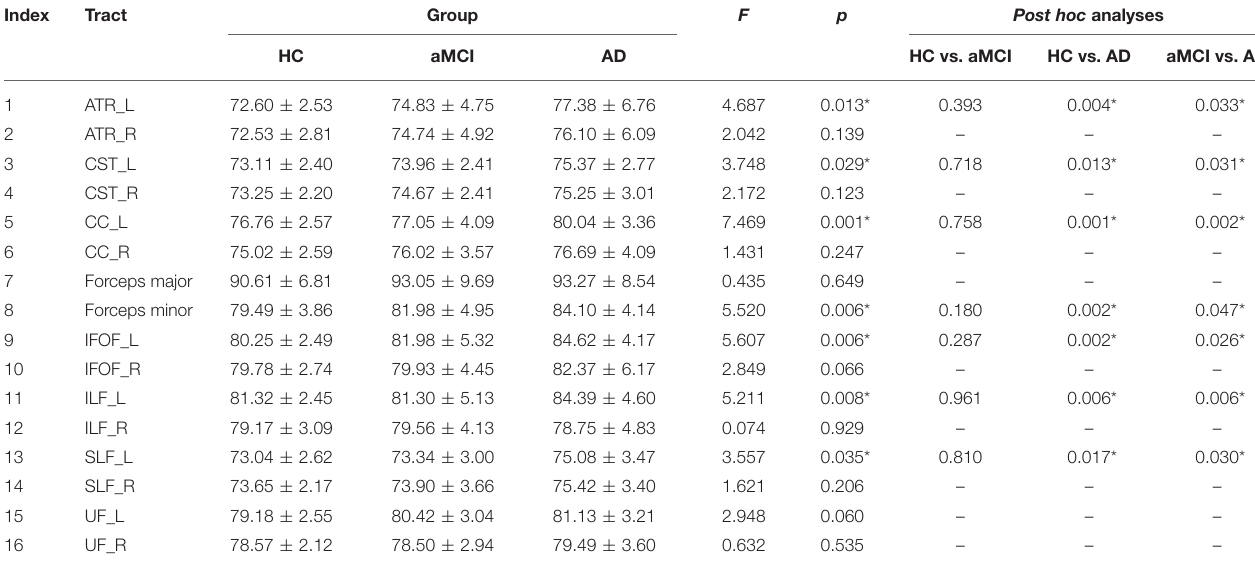
TABLE 2 | Mean MD ( × 100) of 16 fiber tracts for HC, aMCI, and